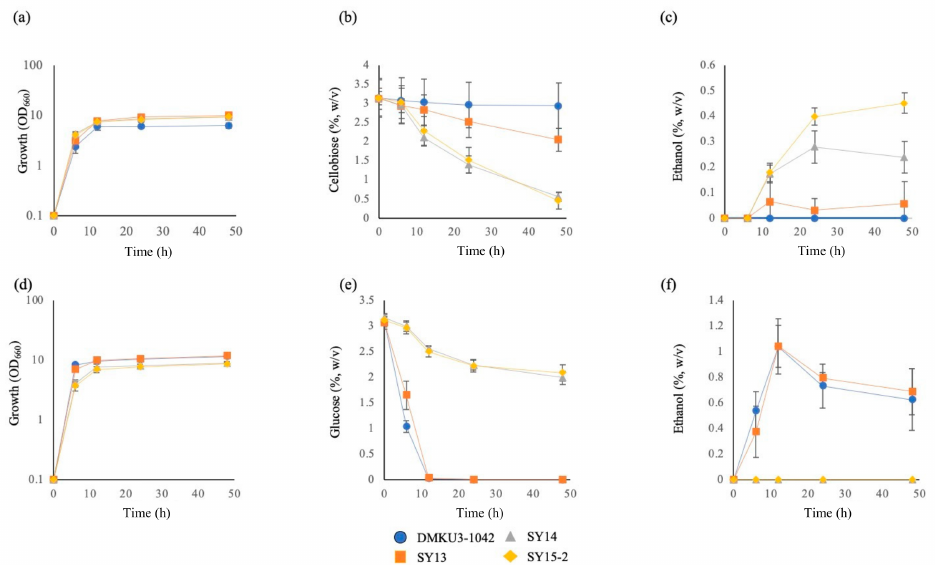
Figure 1. Cellobiose fermentation ability of mutants obtained from K. marxianus DMKU 3-1042. Mutants obtained from K. marxianus DMKU 3-1042 and the parental strain were grown in 30 mL of YAYC ( a – c ) or YAYD ( d – f ) medium at 40 ◦ C under a shaking condition at 160 rpm. ( a , d ) Cell growth was determined by measuring cell density at OD 660 and concentrations of cellobiose ( b ), glucose ( e ) and ethanol ( c , f ) in the culture medium were determined by HPLC as described in Materials and methods. Error bars indicate standard deviation of three independent experiments.